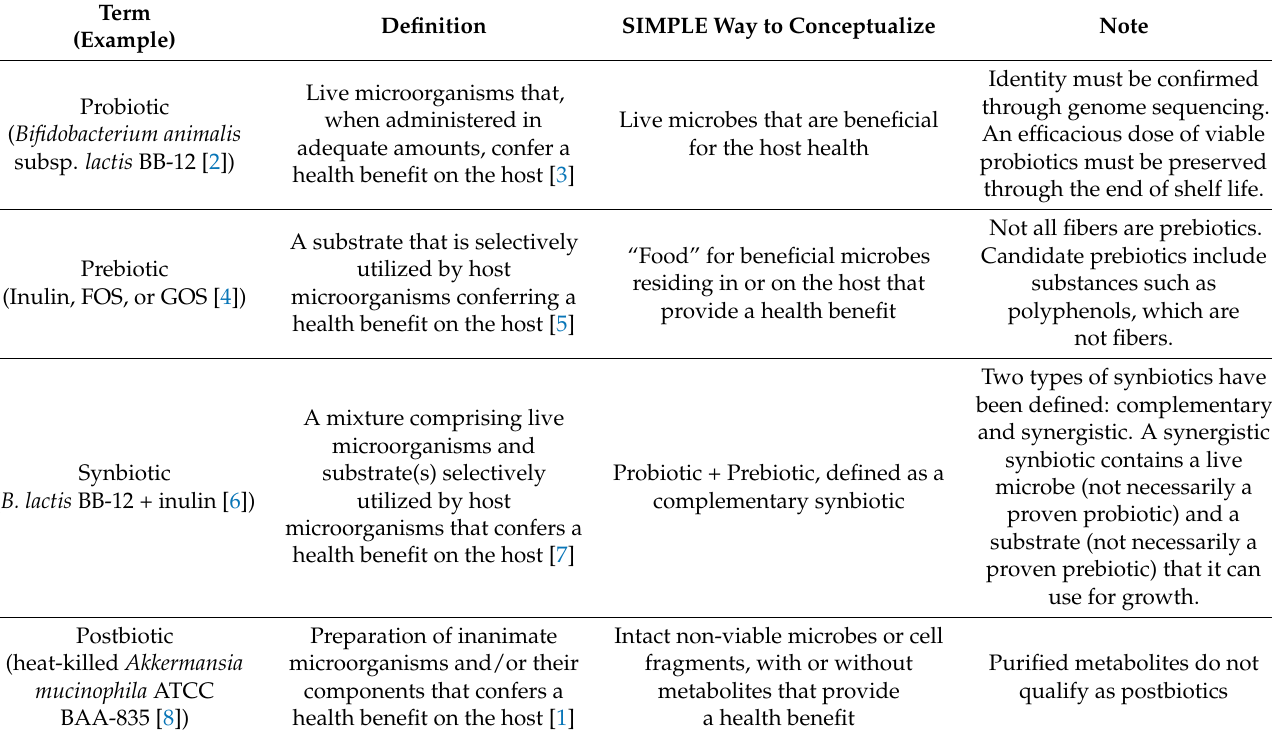
Table 1. Definitions of ‘biotics’ family of substances put forward by consensus panels convened by ISAPP. Note that all substances have been defined in a manner that does not restrict target host, target benefit, regulatory category, site of action on the body or specific mechanism of action. All substances must be safe for their intended use and properly identified/characterized, with a documented health benefit. Adapted from Probiotics, Prebiotics, Synbiotics, Postbiotics and Fermented Foods – defined, © 2021, International Scientific Association for Probiotics and Prebiotics.